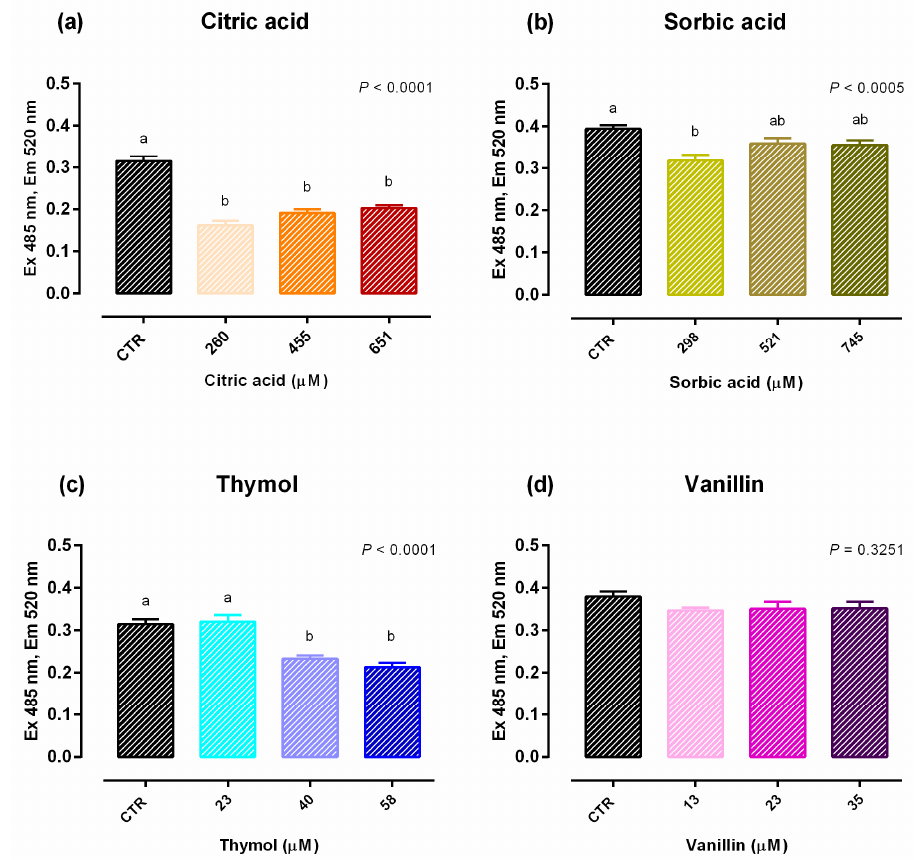
Figure 2. PCP of Caco-2 cells grown with single OA and NIC. Data in the graph are means ( n = 6) ± SEM represented by vertical bars. Means with different letters indicate statistical significance with p < 0.05 (a, b); means with at least one common letter are not significantly different (ab). PCP = paracellular permeability (excitation 485 nm, emission 520 nm). ( a ) Cells treated with citric acid; CTR = control group; 260 = treated group with 260 µM of citric acid; 455 = treated group with 455 µM of citric acid; 651 = treated group with 651 µM of citric acid. ( b ) Cells treated with sorbic acid; CTR = control group; 298 = treated group with 298 µM of sorbic acid; 521 = treated group with 521 µM of sorbic acid; 745 = treated group with 745 µM of sorbic acid. ( c ) Cells treated with thymol; CTR = control group; 23 = treated group with 23 µM of thymol; 40 = treated group with 40 µM of thymol; 58 = treated group with 58 µM of thymol. ( d ) Cells treated with vanillin; CTR = control group; 13 = treated group with 13 µM of vanillin; 23 = treated group with 23 µM of vanillin; 35 = treated group with 35 µM of vanillin.